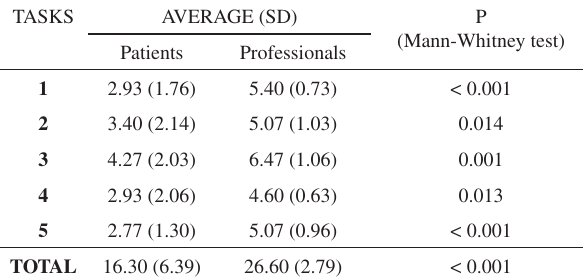
Table 4 – Construct validity of the GBT